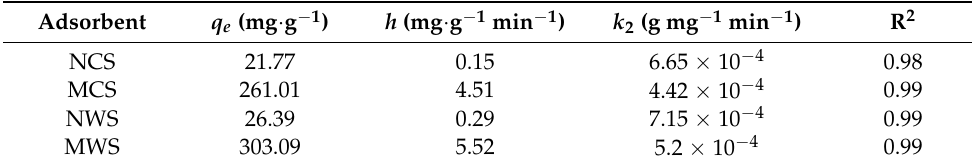
Table 4. Pseudo-second-order kinetic parameters for Pb(II)